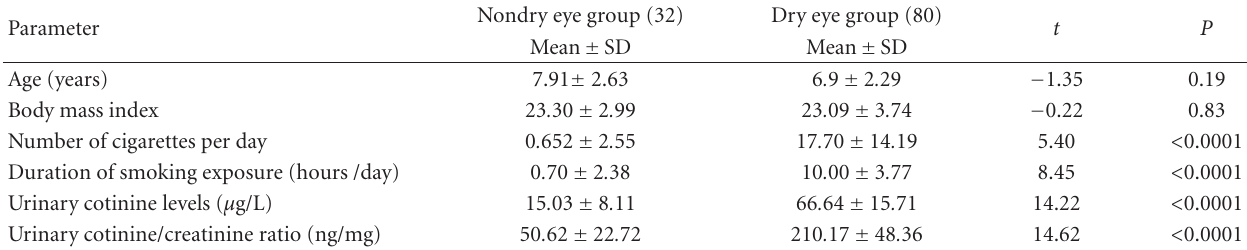
Table 2: Age, body mass index, and smoking parameters between children with dry eye compared to those without dry eye. Parameter